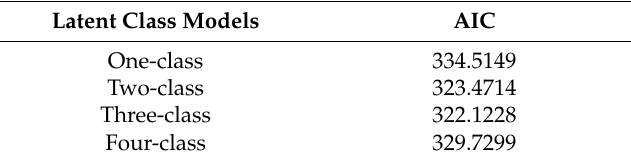
Table 2. Statistical comparison of latent class